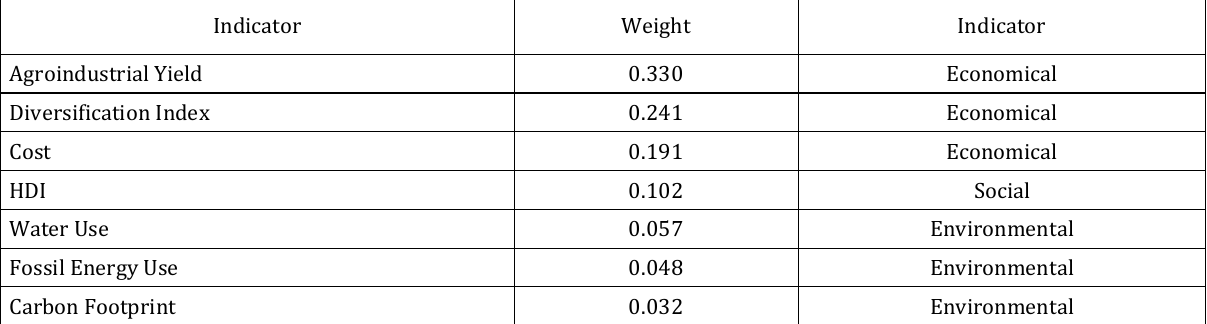
Table 5. Relative weight of indicators